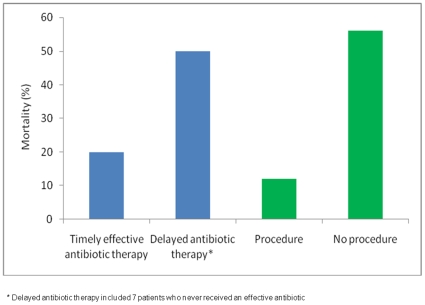
Timely effective antibiotic therapy and procedures for infectious source control significantly improved outcome.Administration of an effective antibiotic on the same day as the positive culture was taken significantly reduced all-cause mortality (p<0.001), as did undergoing a procedure for infectious source control (p<0.001).